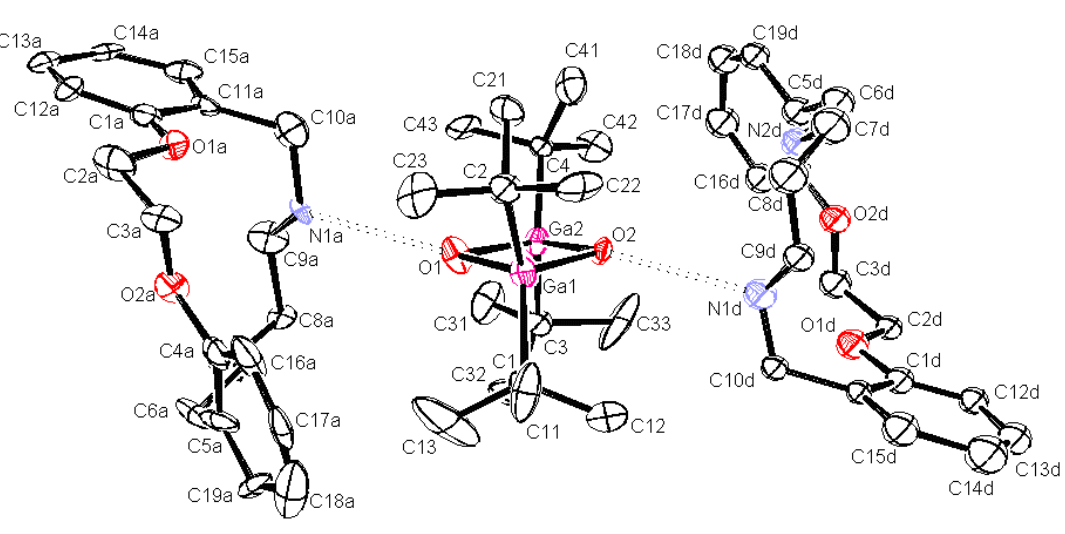
Figure 1 . Packing diagram showing the hydrogen bonding interactions for half the interactions in [( t -